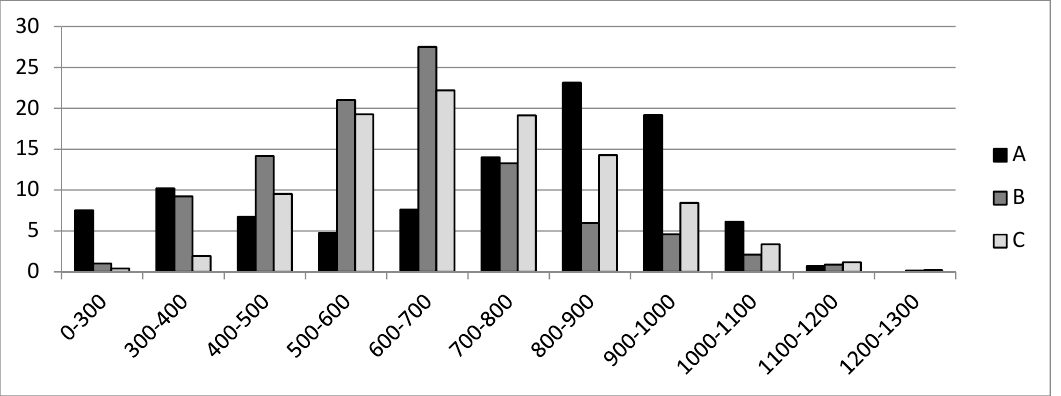
Figure 4. Area distribution for elevation classes (% of area vs. elevation classes in meters).